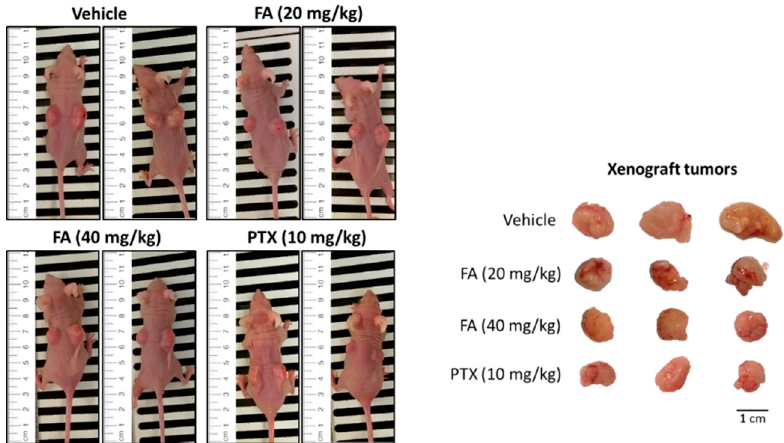
Figure 8. The antitumor efficacy of FA in HCT-116 xenograft-bearing nude mice. When the xenograft tumors reached about 100 mm 3 , vehicle solution, FA (20 or 40 mg/kg), or PTX (10 mg/kg) was intraperitoneally administered to the tumor-bearing mice every other day for 14 days. The subcutaneous tumors were excised at the end of the animal